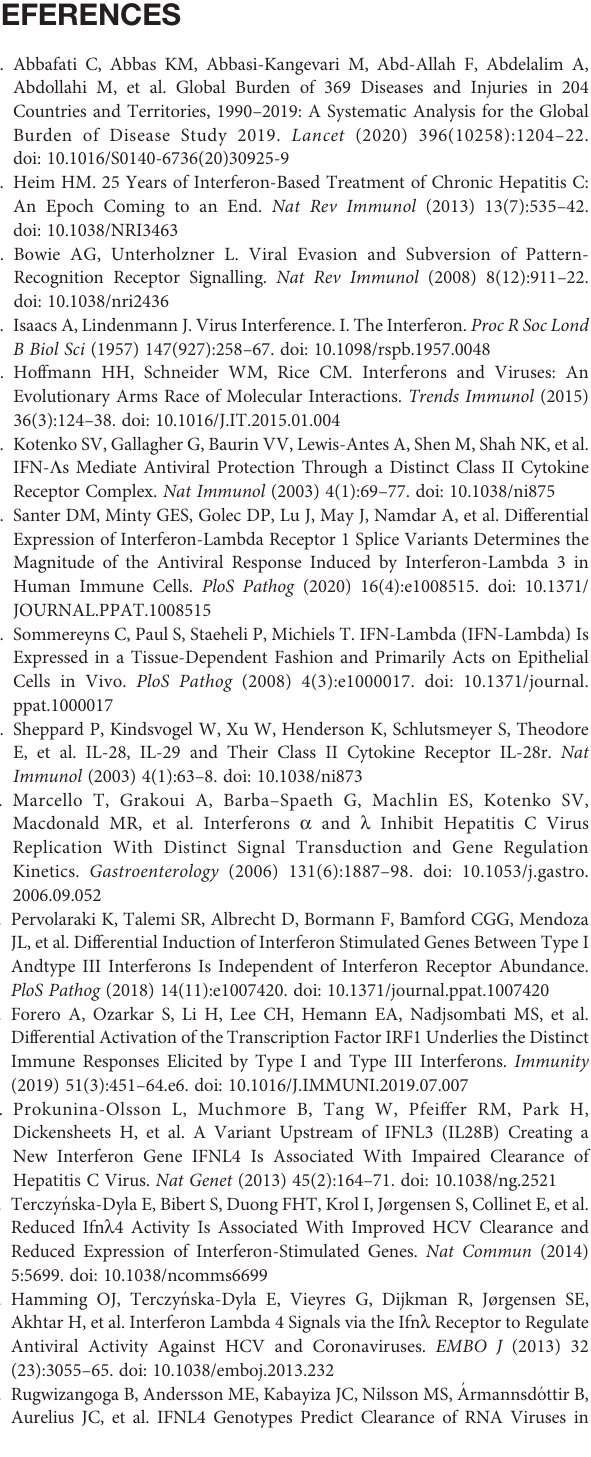
Supplementary Figure 2 | Effect of IFN incubation time on kinetics of human IFN l variants. HepaRG cells were stimulated with IFN l s: IFN l 3-HiBiT (red), IFN l 4-